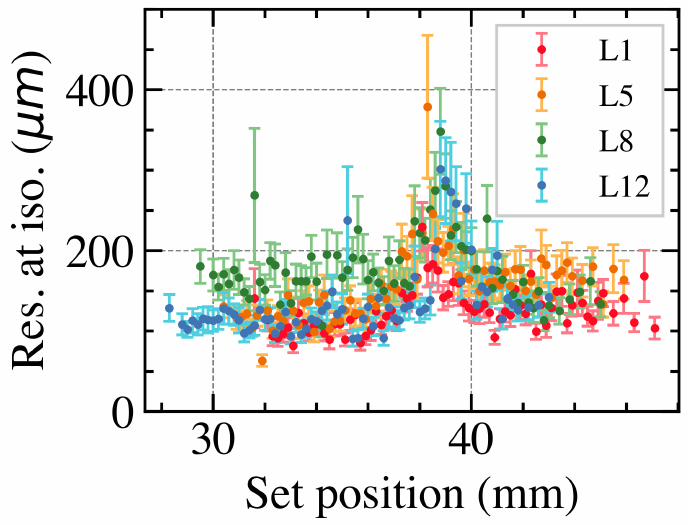
Figure 4. Reconstructed MLC leaf position resolution as a function of the set position for 4